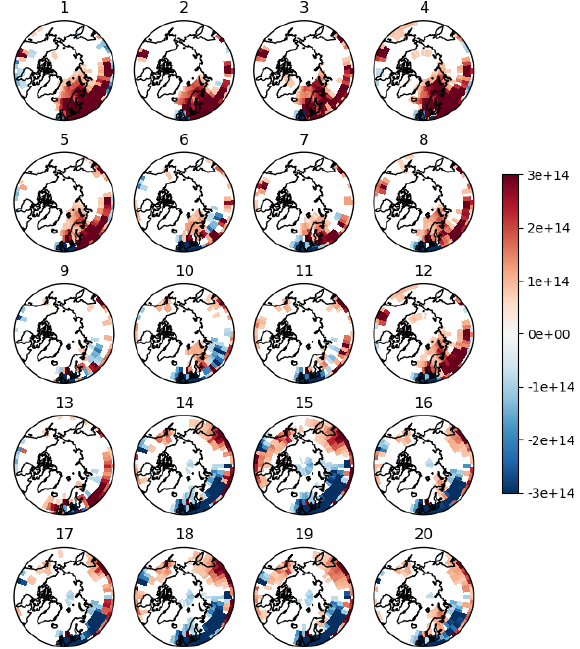
Figure A4. NO 2 total column anomalies (moleculescm − 2 ) based on OMI data for the 20 circulation types. Only those anomalies that are statistically significant at the 90% confidence level are shown.